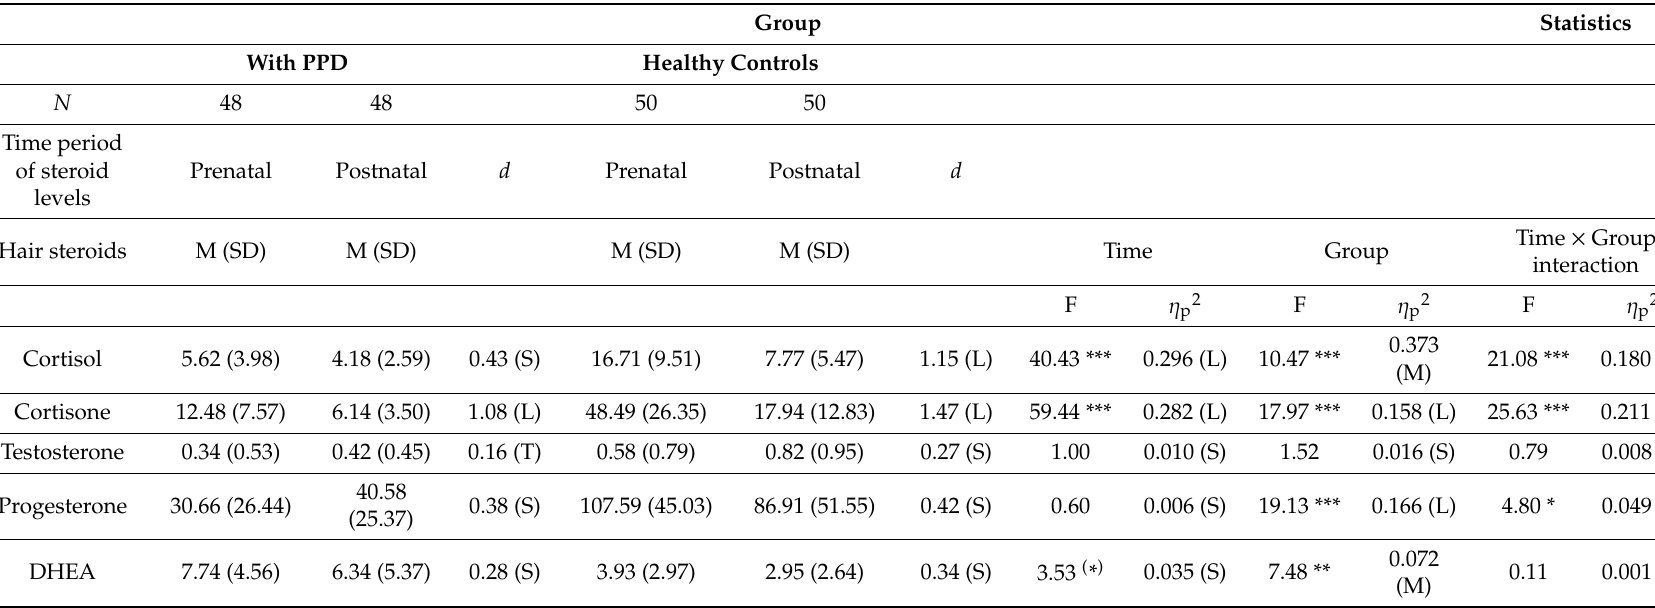
Table 1. Descriptive and inferential statistical indices of hair steroids, separately for participants with ( n = 48) and without ( n = 50) postpartum depression. Group Statistics With PPD Healthy Controls N 48 48 50